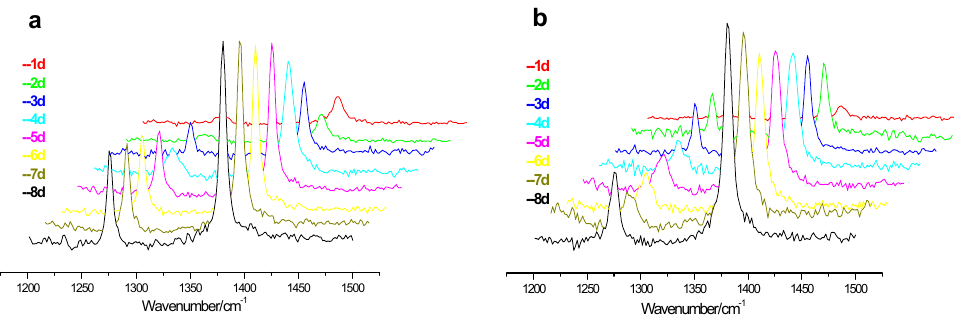
Figure 3. The Raman spectroscopy change of CO 2 hydrate at point “A” for experiment 1 ( a ) and experiment 2 ( b ), where the 1d, 2d, 8d represent the first, the second, the eighth day of the experiment process.